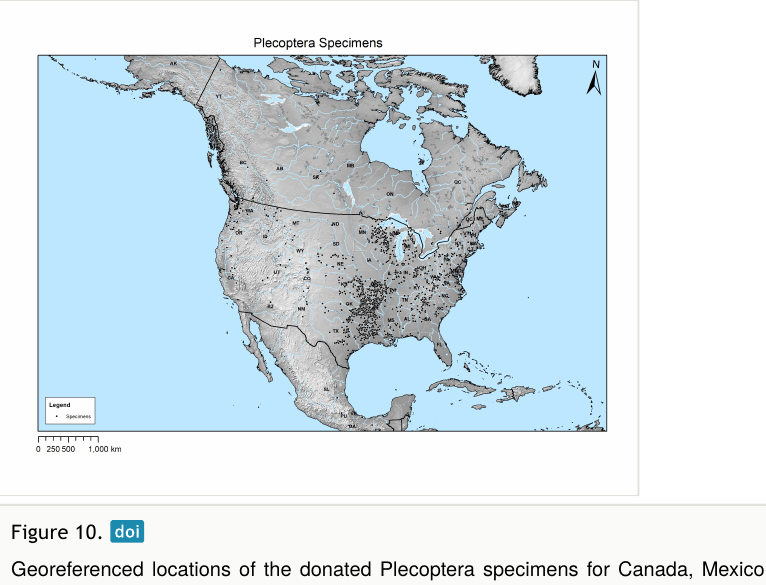
Figure 10. Georeferenced locations of the donated Plecoptera specimens for Canada, Mexico, and the United